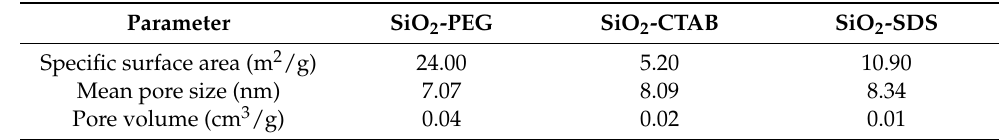
Figure 3. Adsorption-desorption isotherms of ( a ) SiO 2 -SDS, ( b ) SiO 2 -CTAB and ( c ) SiO 2 -PEG. Table 2. Brunauer–Emmet–Teller (BET) and Barret–Joyner–Halenda (BJH) analysis results of SiO 2 - CTAB, SiO 2 -SDS, and SiO 2 -PEG